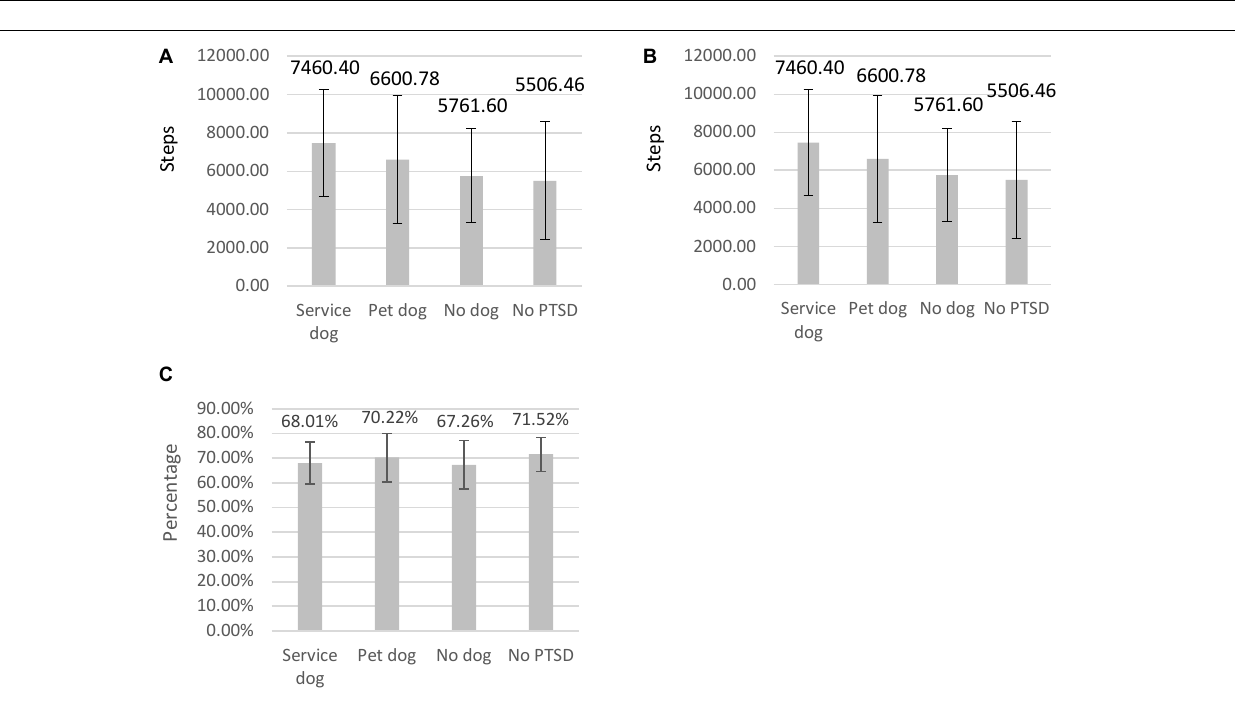
FIGURE 1 | The salivary cortisol levels for the four different subject groups during five different measurement points. The four groups are: individuals with PTSD and a service dog, individuals with PTSD and a companion dog, individuals with PTSD without a dog, Individuals without PTSD. The five measurement moments are: Just after waking up ( n = 19, 10, 11, 21), 15 min after waking up ( n = 20, 10, 12, 22), 30 min after waking up ( n = 20, 10, 12, 22), 60 min after waking up ( n = 17, 10, 12, 22), just before going to bed in the evening ( n = 19,10,12,22).